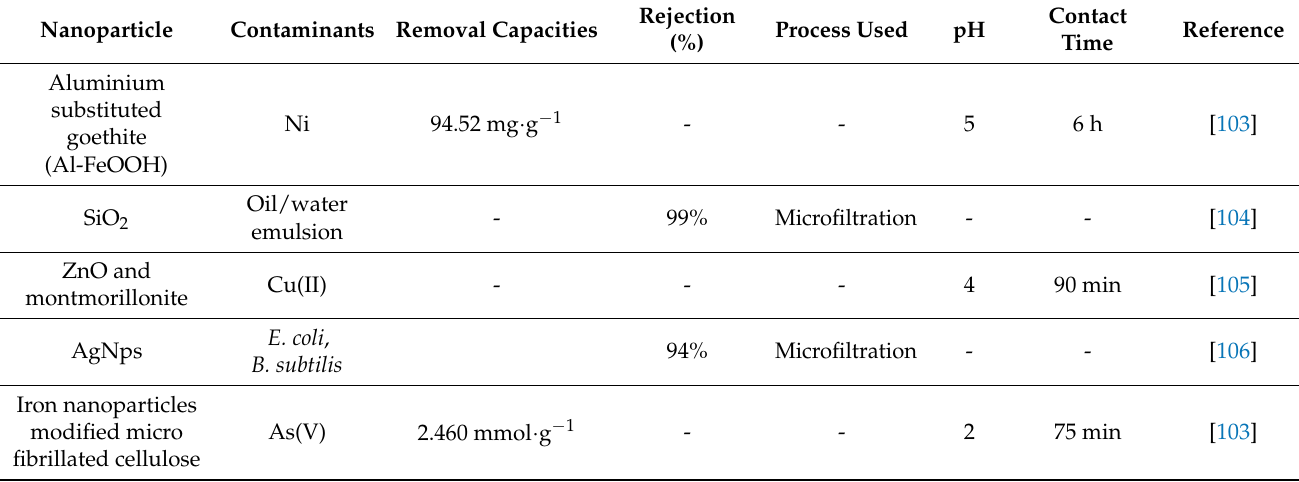
Table 6. Application of nanoparticles in the removal of contaminants from